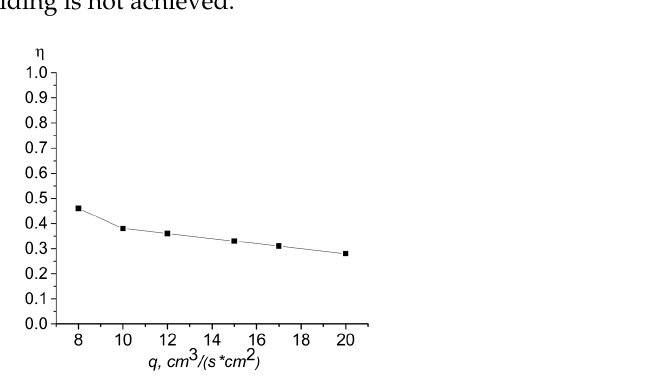
Table 1. Maximum temperature and burning rate of chromium in nitrogen.